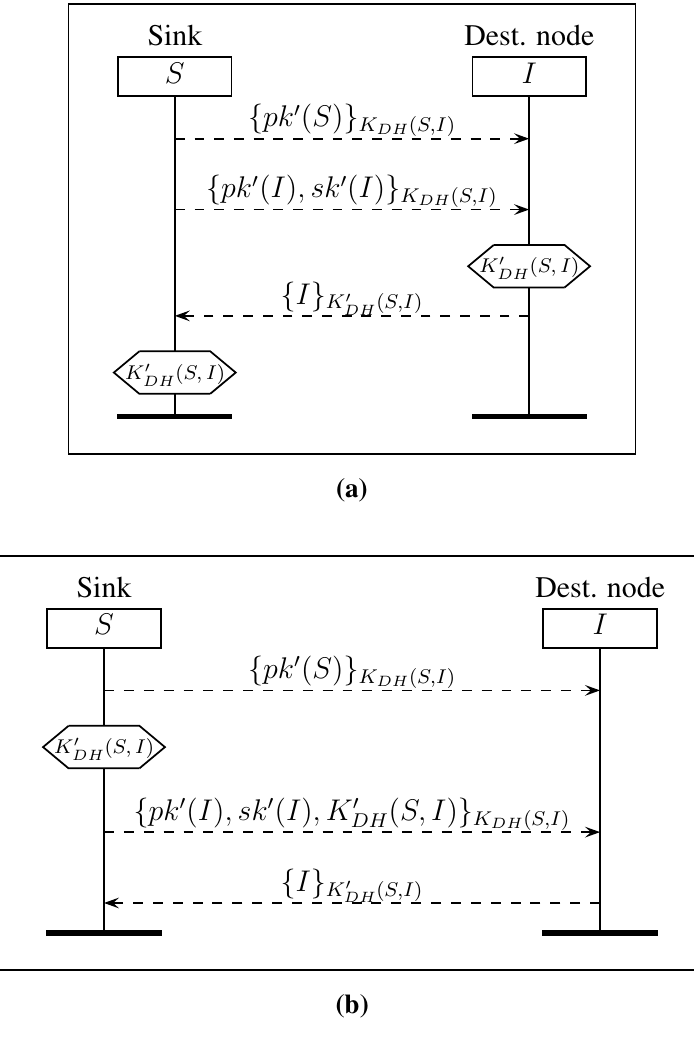
Figure 5. Two protocols for renewing the new asymmetric keys of a node I , where S uses the symmetric shared key K ( S, I ) to deliver pk ′ ( S ) to I . ( a ) Protocol RAKdh DH